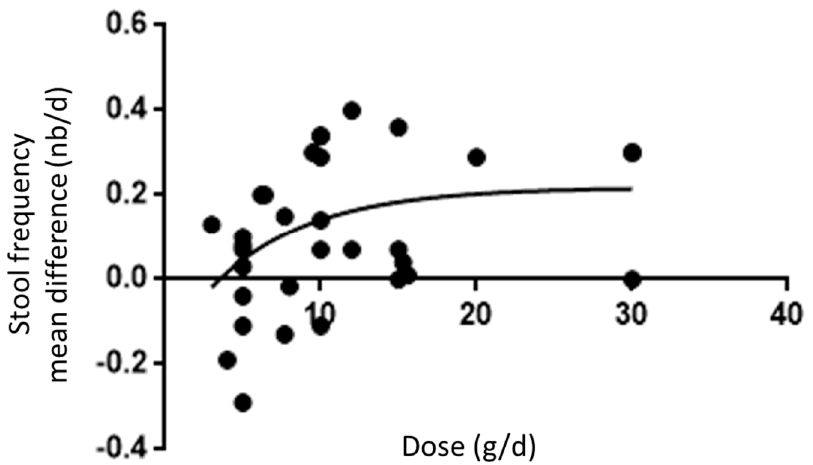
Figure 6. Dose-response curve for the effect of β -fructans on delta mean stool frequency. Sigmoidal relationship applying Pseudo-Hill modelling between the dose of β -fructans applied and the difference in outcome in stool frequency between consumption of β -fructans versus that of placebo expressed as the difference in mean values (number of bowel movements/day). Each point represents one single study.